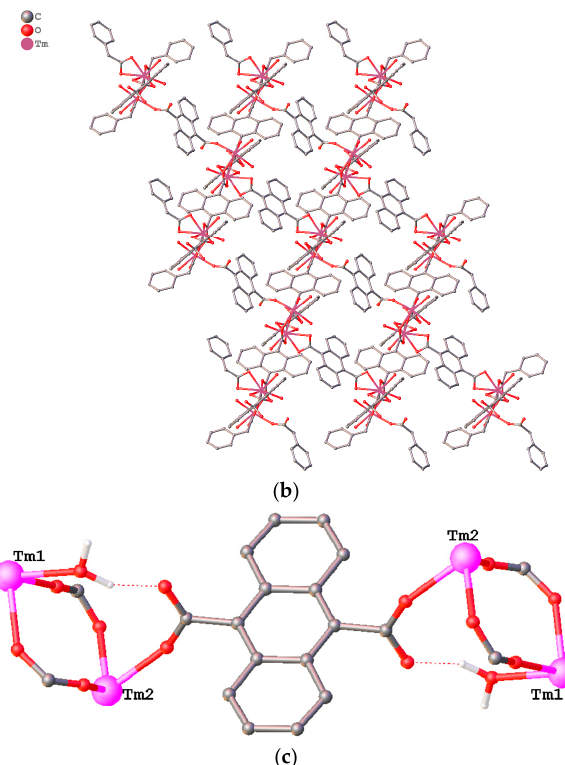
Figure 2. ( a ) The coordination environment of Tm1 and Tm2 in 4 . ( b ) Interconnectivity of two chains with the ADC units in bis -chelating and bis -monodentate coordination modes along the (010) direction. ( c ) Hydrogen bonding between ADC and coordinated water molecules . (Coordinated solvent molecules are omitted for clarity).